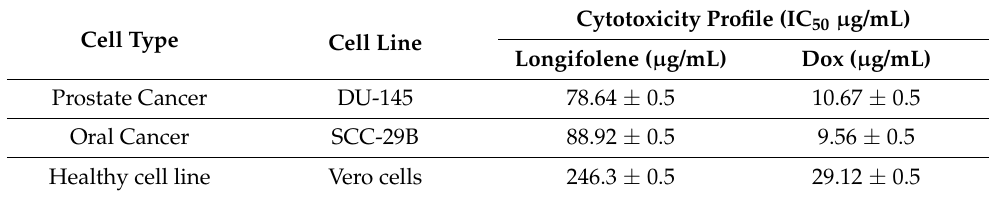
Table 4. Cytotoxicity profile with IC 50 ( µ g/mL) values of longifolene and